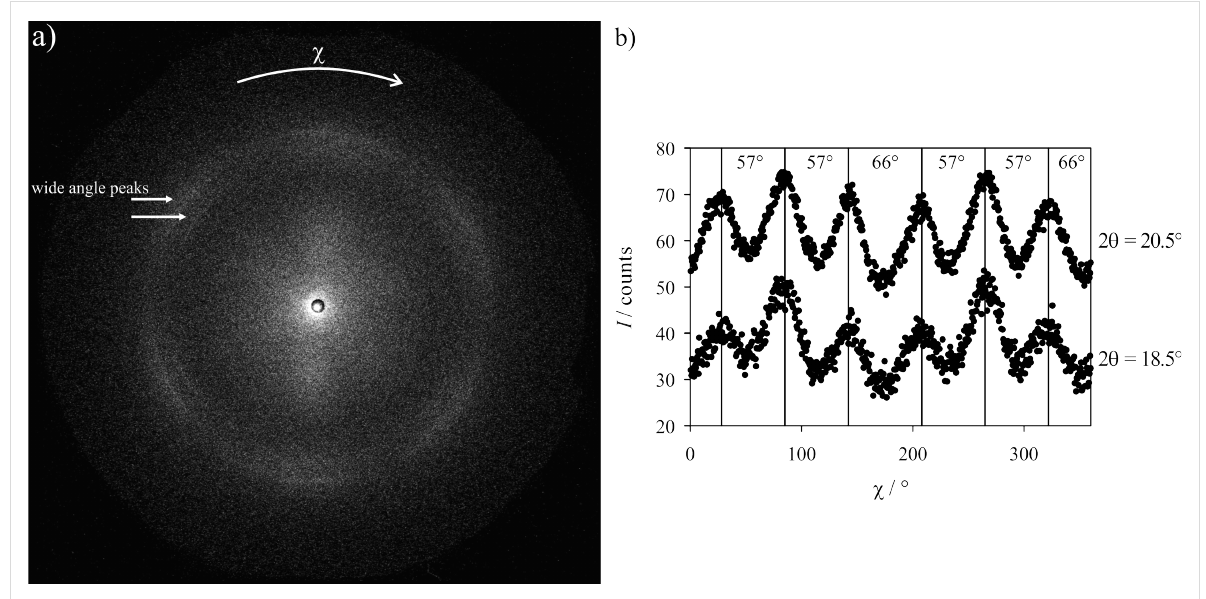
In the 2-D diffractogram (Figure 10a), no layer peak could be observed as the layer normal was oriented parallel to the